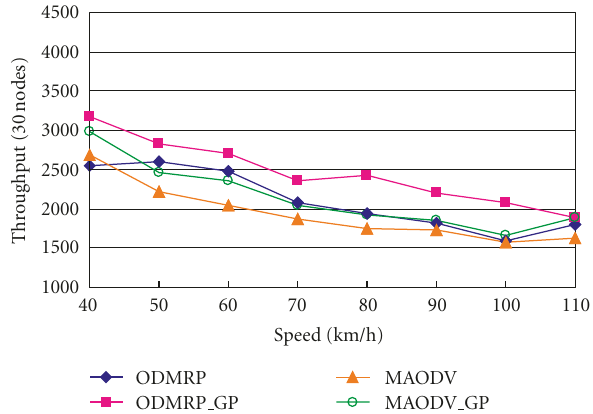
Figure 16: Throughput versus mobility speed (30 nodes).